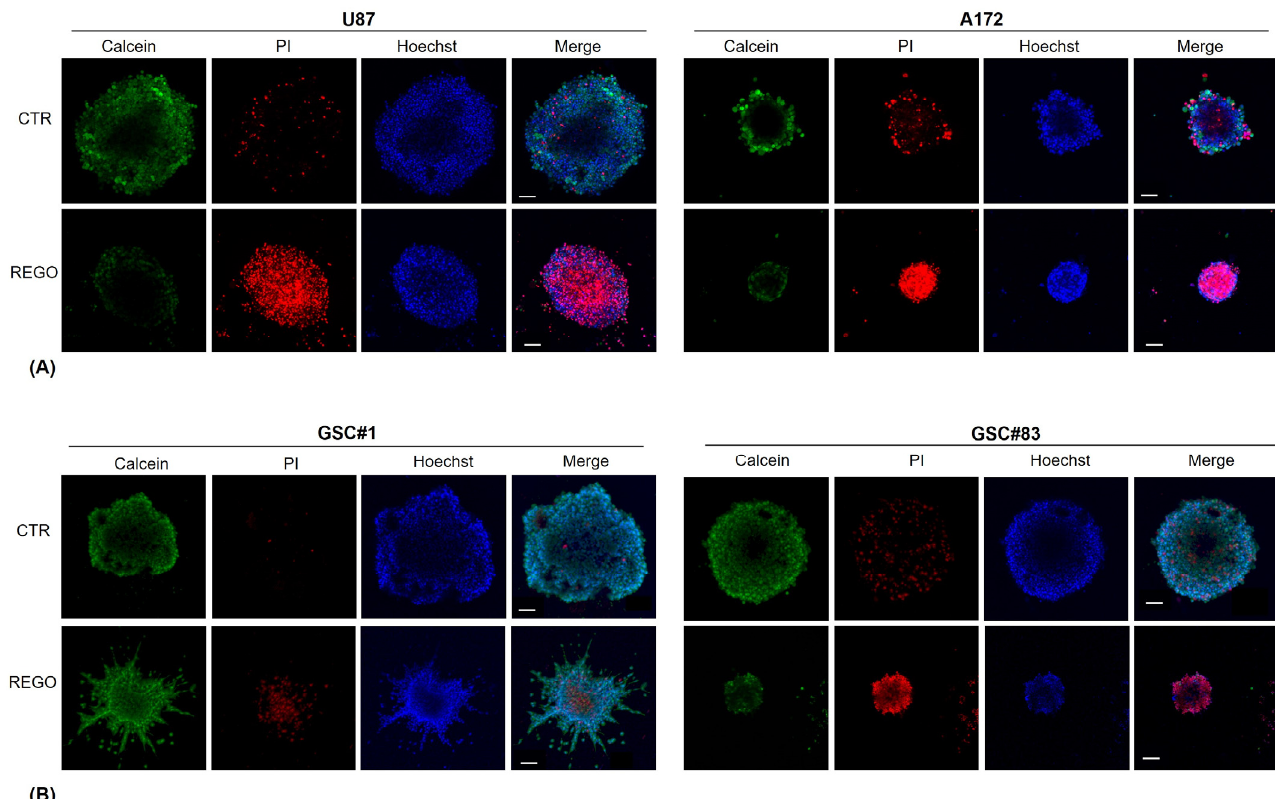
Figure 8. Combined fluorescence images of 3D tumor U87 and A172 (A) and GSCs (B) spheroids. Tumor spheroids were stained with calcein, propidium and Hoechst, for staining metabolically active cells, dead cells, and cell nuclei, respectively, and analyzed by confocal microscope. Magnification 10×, scale bar 100 μ m.